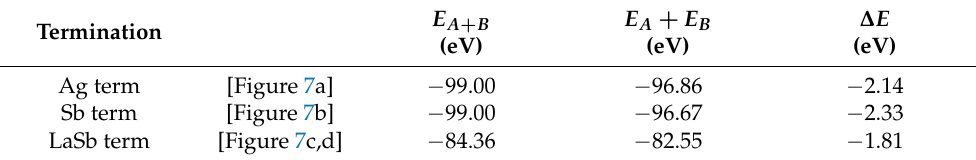
Table 1. The comparison of the binding energies ∆ E (as a difference between the energy of the surface E A + B , and energy of individual reactants E A + E B ) for different terminations (as labeled). E A + B E A + E B ∆ E Termination (eV) (eV) (eV) Ag term [Figure 7a] − 99.00 − 96.86 − 2.14 Sb term [Figure 7b] − 99.00 − 96.67 − 2.33 LaSb term [Figure 7c,d] − 84.36 − 82.55 −